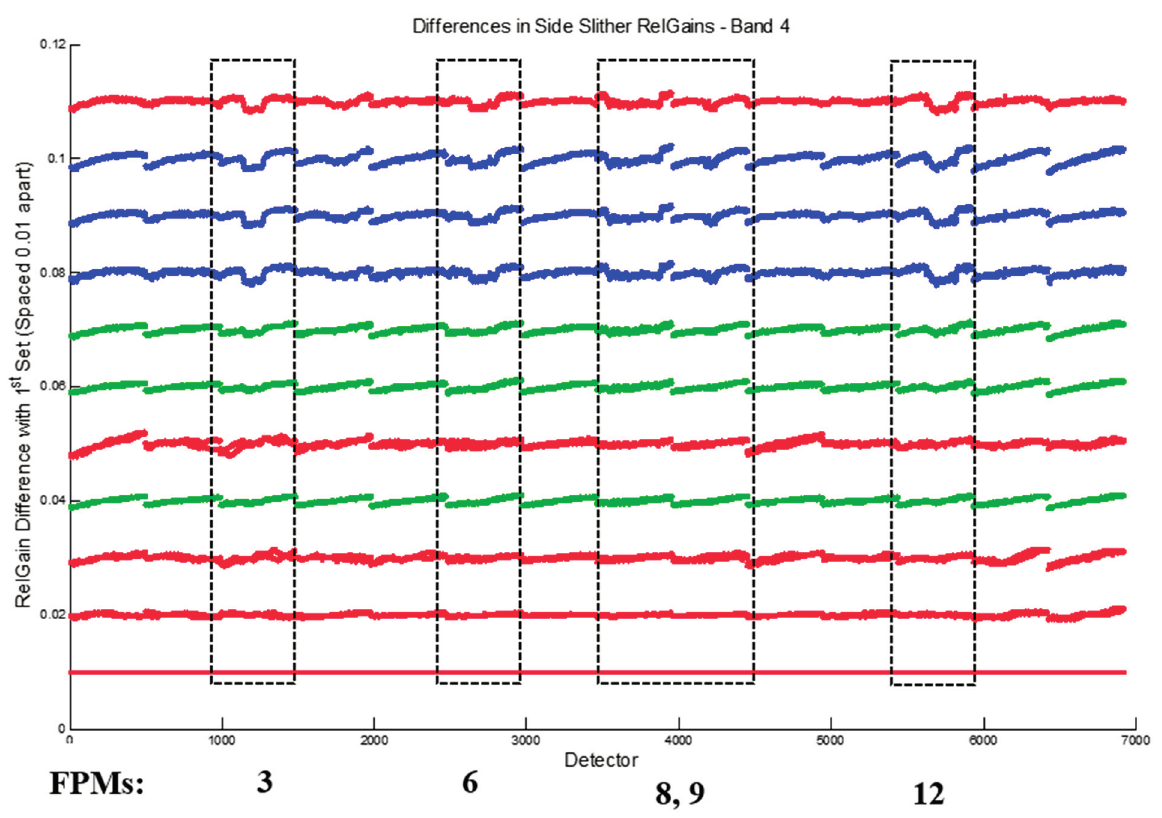
Figure 6. Temporal differences between side-slither relative gains in the red band using the first set as a basis. Note that each collect is color-coded by the region slithered: red for desert, green for Greenland and blue for Antarctica. Boxed FPMs are numbered below the